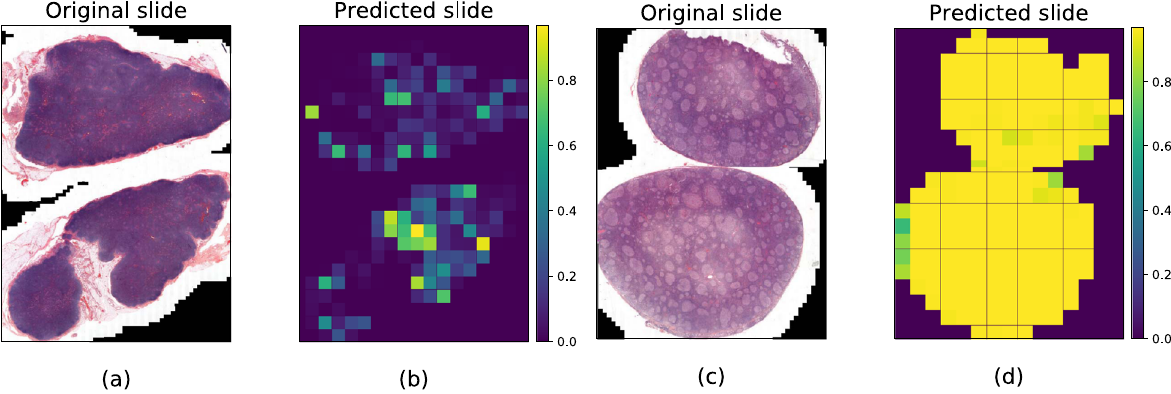
Fig. 3 Patch classi fi cation visualisation on WSI for follicular hyperplasia (FH) and follicular lymphoma (FL) from the test set. Each predicted patch at resolution 7.84 µm/pixel is coloured by FL probability predicted by the system. a and b FH slide has very low FL probability on every patch. c and d FL probability is close to 1 everywhere on the FL slide.